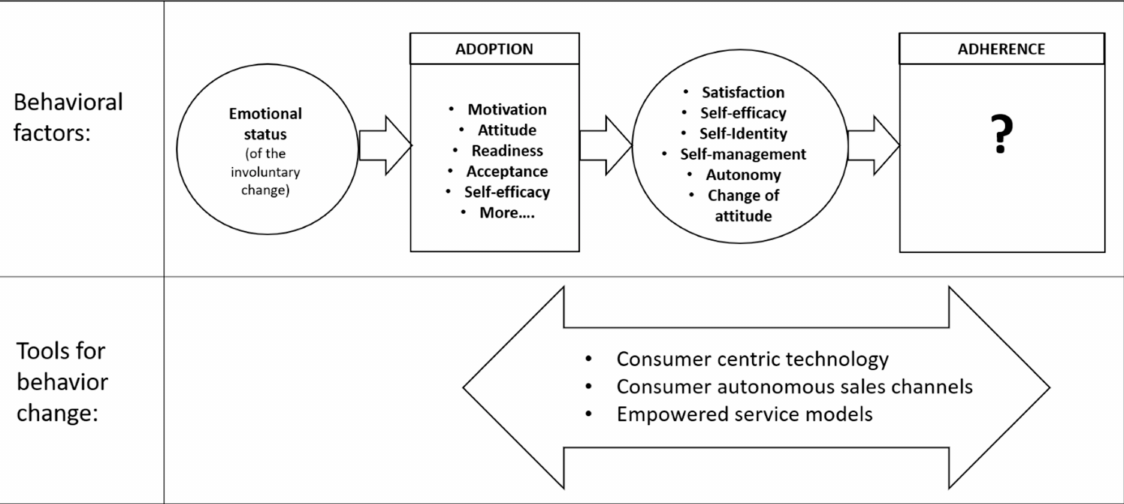
Figure 1. Overview of current knowledge to support sustained behavior change in chronic health management of hearing